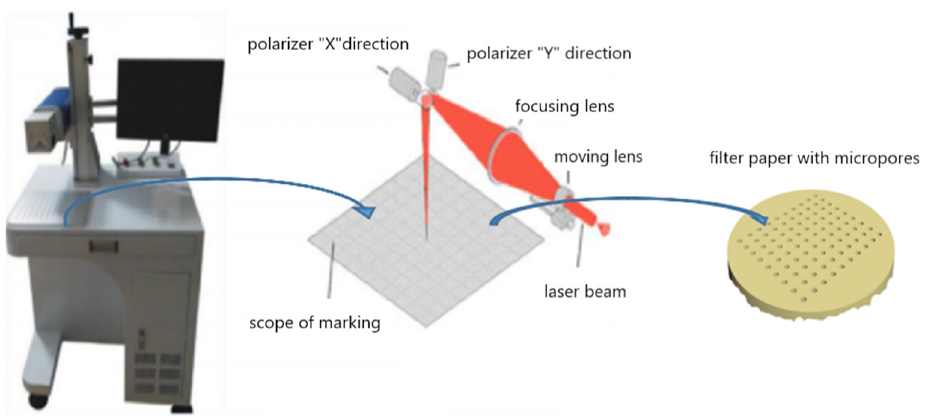
Figure 1. Schematic of optical setup for the fabrication of micropore on the filter paper using the nanosecond laser engraving machine.